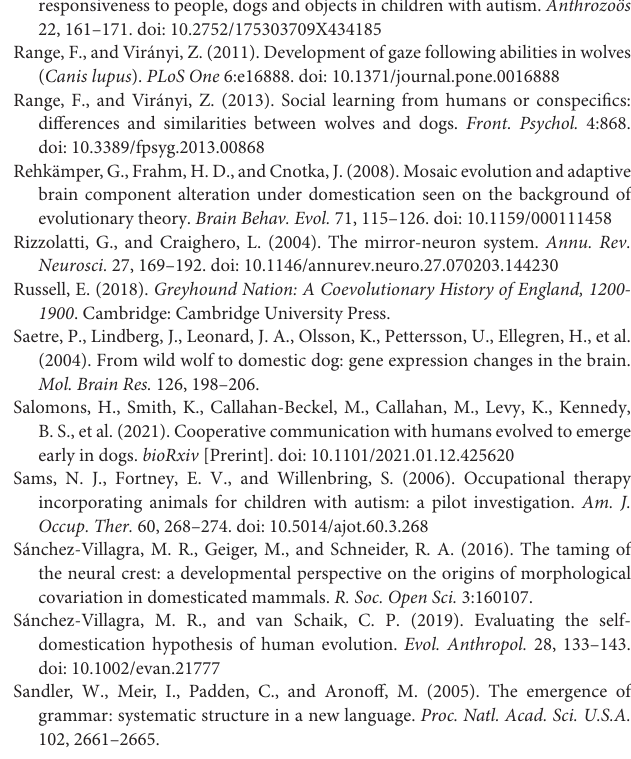
verbal referents. Behav. Process 86, 184–195. doi: